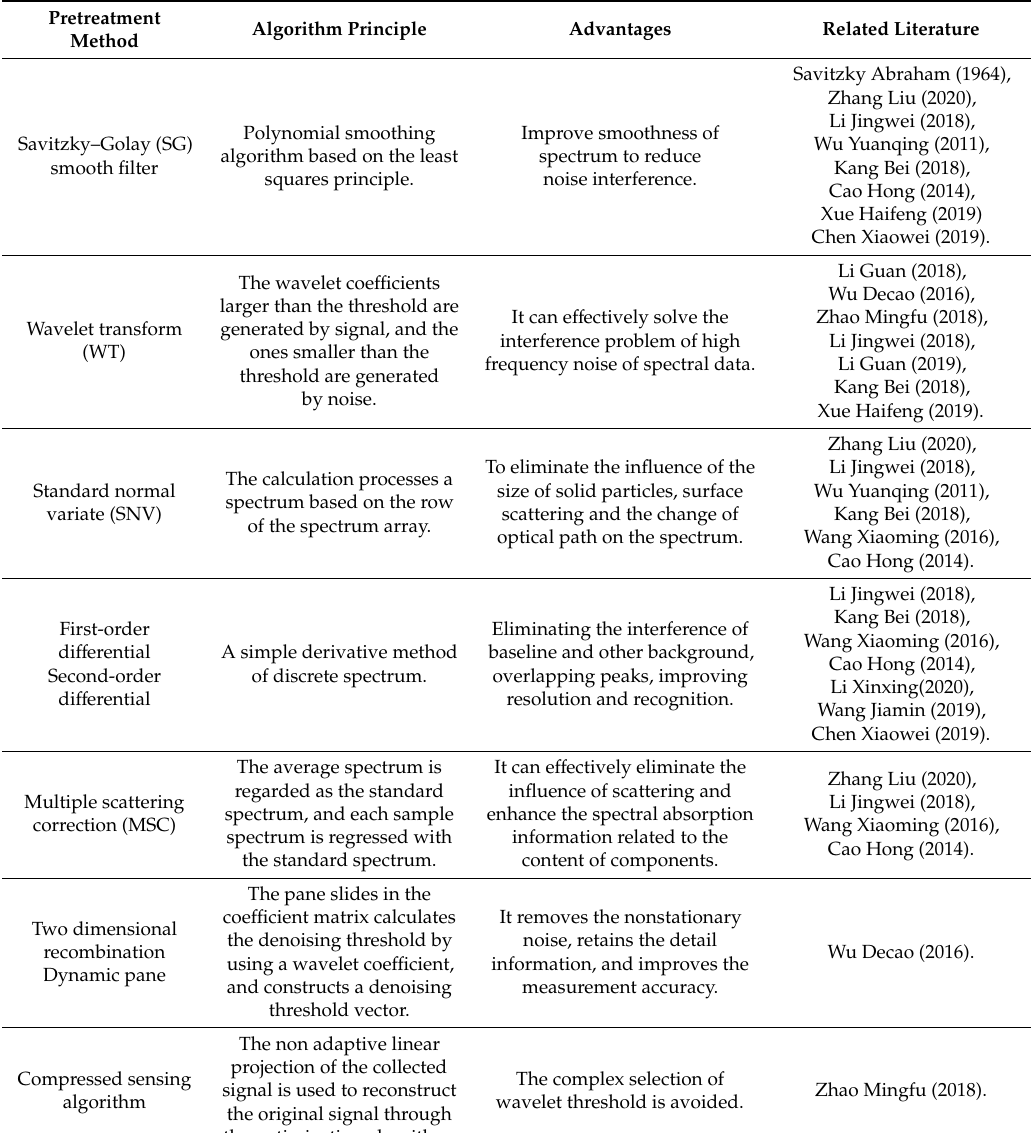
Table 2. Algorithms for reducing spectral data